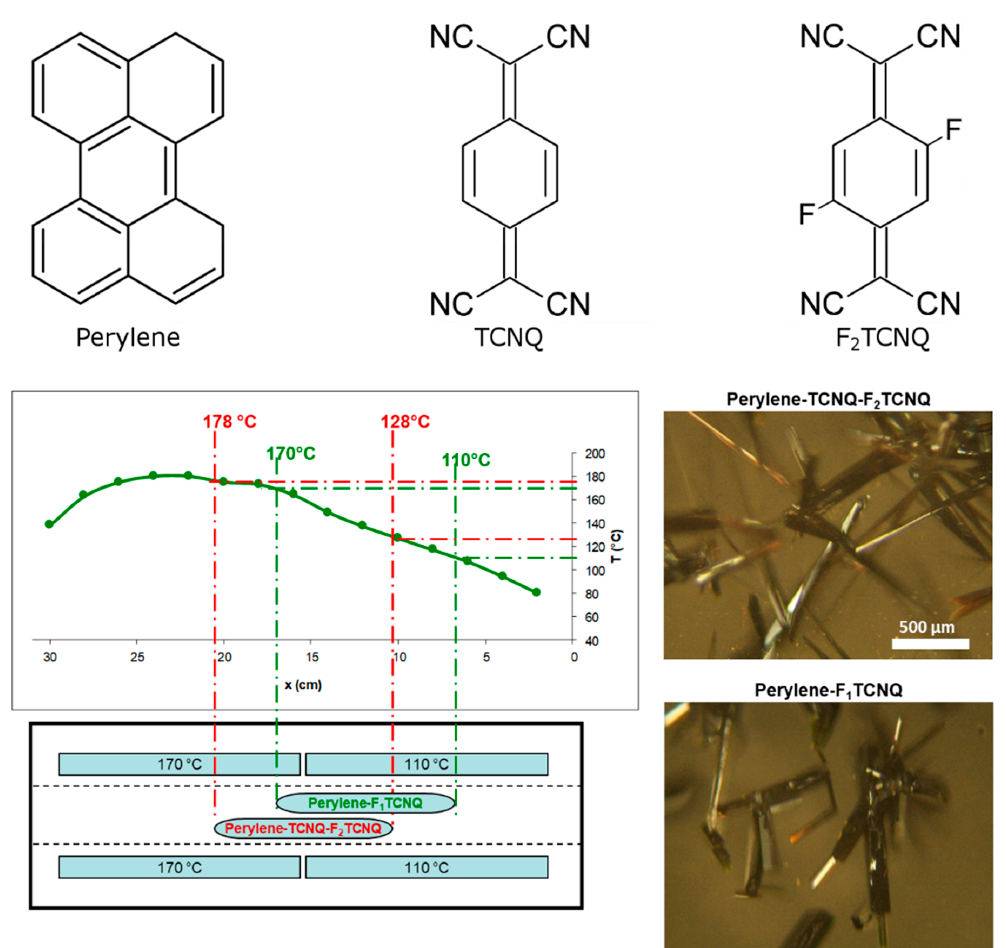
Figure 1. Chemical formulas (top), scheme of the PVT crystal growth technique (bottom left), and photographs of the grown crystals (bottom right).